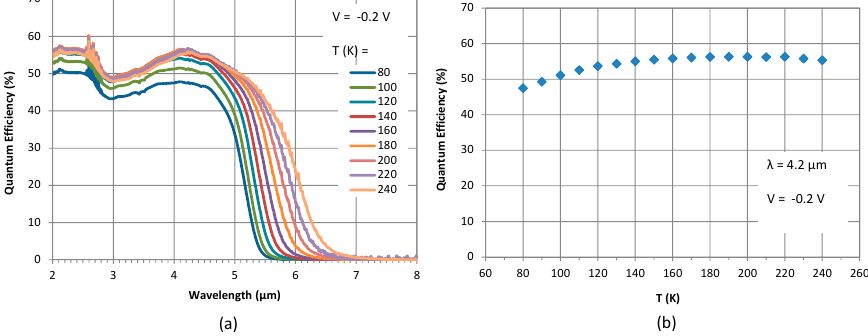
Figure 5. ( a ) Spectral quantum efficiency of the detector at –0.2 V at various temperatures and ( b ) variation of the peak quantum efficiency with temperature at 4.2 µm under –0.2 V.